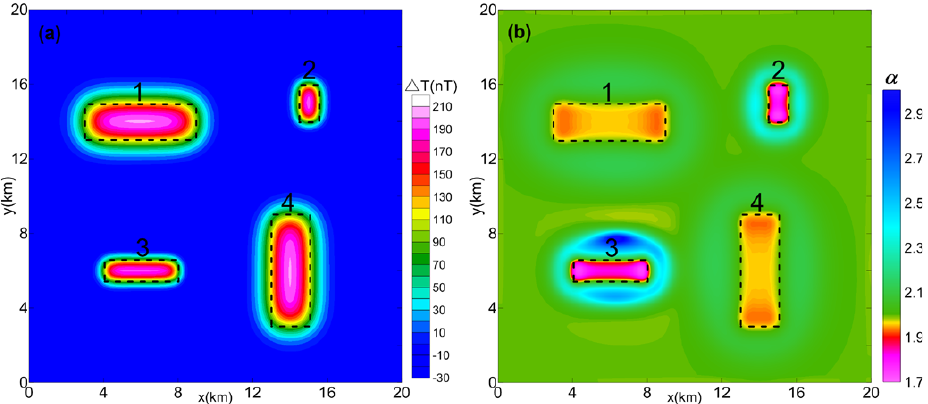
Fig. 5. Illustration showing magnetic source edge detection using the singularity mapping technique: (a) theoretical magnetic anomalies produced by four rectangular models; (b) estimated local singularity α value. The black dotted lines indicate the boundaries of the four rectangular